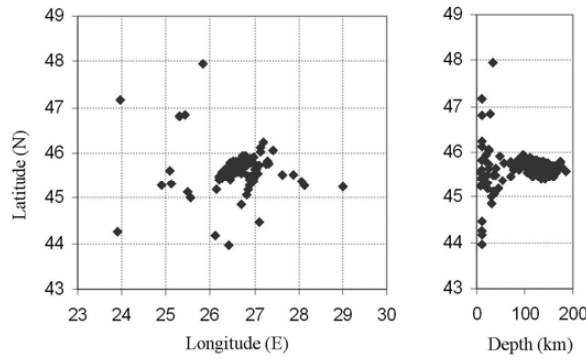
Fig. 1. Vrancea zone.